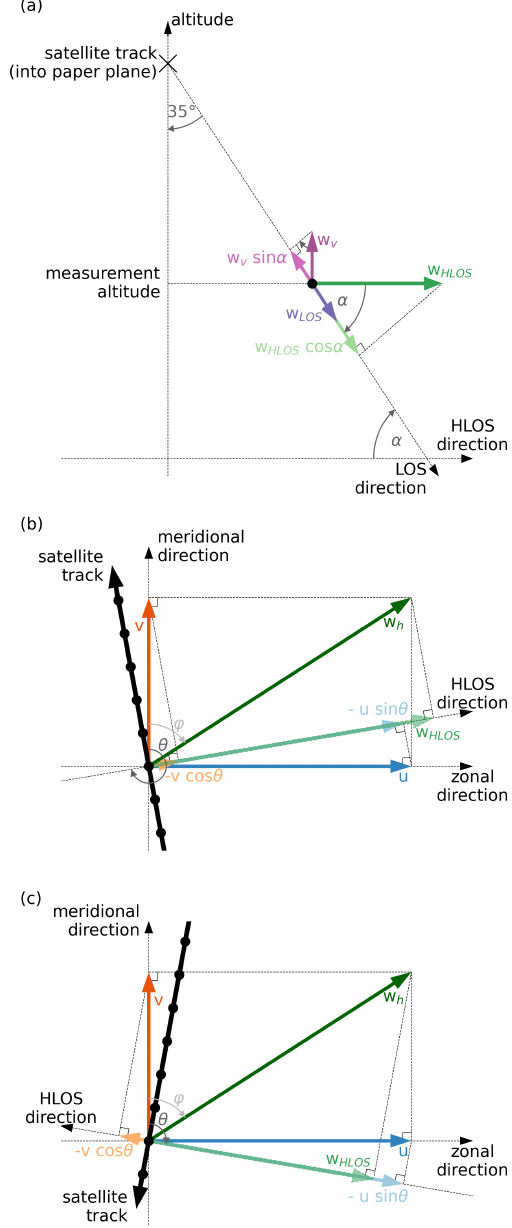
Figure 1. Measurement geometry of Aeolus. Panel (a) is in the vertical along-line-of-sight plane and panels (b) and (c) show the horizontal plane for ascending and descending orbits, respectively, for typical track angles of 10 ◦ from north. For better illustration, panel (a) shows a situation with extraordinary strong vertical wind w v .